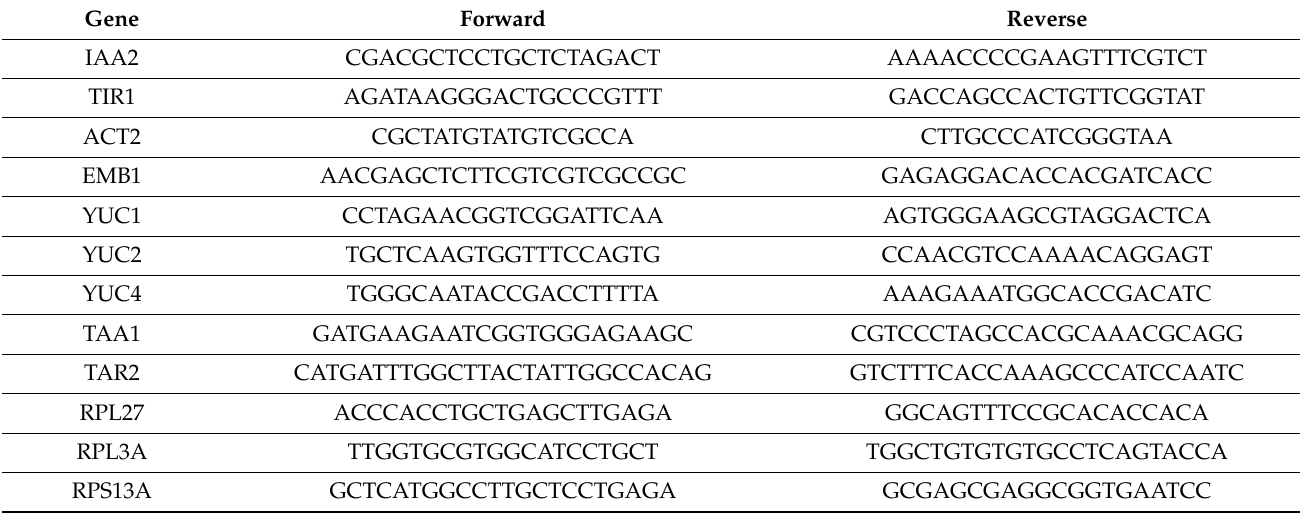
Table 4. Primers for